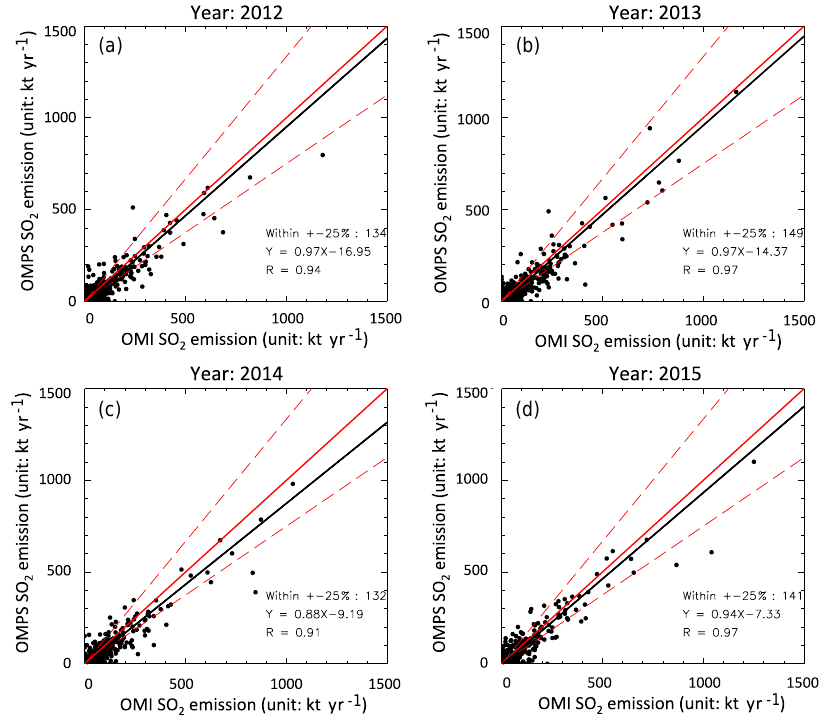
Figure 9. Scatterplots comparing the annual SO 2 emissions estimated using OMPS and OMI retrievals for 403 sources (see Fig. 8 for their locations) indicate generally good agreement between the two datasets, with correlation coefficients between 0.91 and 0.97 and slopes between 0.88 and 0.97.